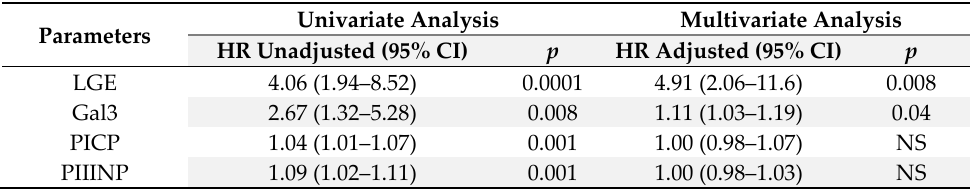
Table 4. Univariate and multivariate Cox analysis for